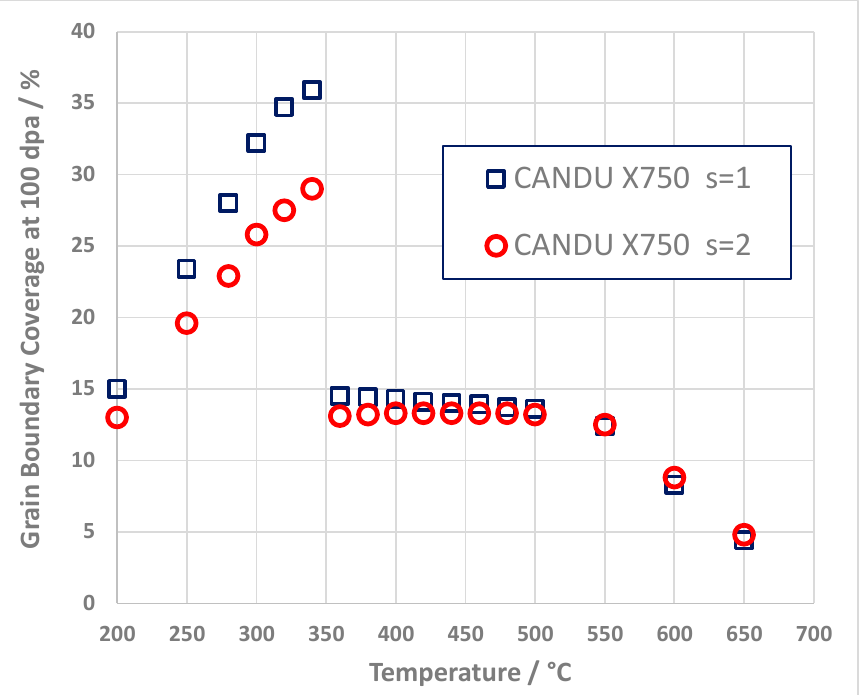
Figure 16. Calculated grain boundary cavity coverage as a function of temperature after 30 years of operation for Inconel X-750 material (100 dpa) irradiated in a neutron spectrum typical of a CANDU reactor core for two values of cavity surface energy (s = 1 or 2 J.m − 2 ) and assuming an arbitrary shift from bubble to void-swelling regimes at temperatures >350 °C.